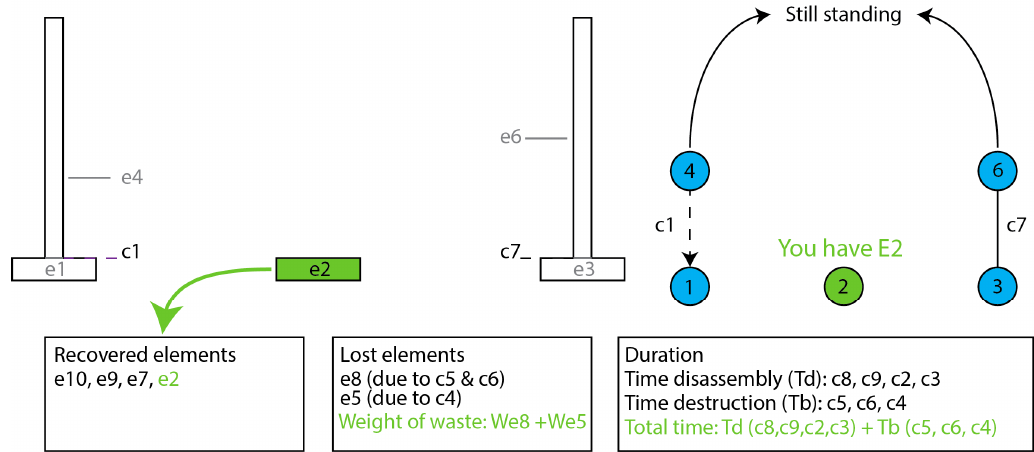
Figure 11. The disassembly sequence, the filtering of element (into lost or recovered elements), and the calculation of the total disassembly time are calculated sequentially after having determined the elements and connections that need to be removed to get the element (shortest path) and to be able to remove it (interdependencies).